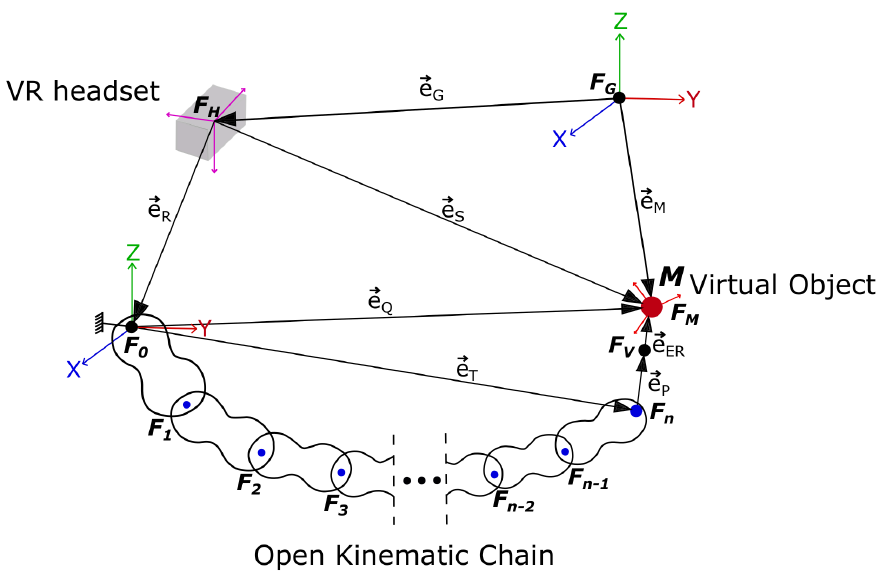
Figure 1. Kinematics Representation of n DoF Upper-Limb Exoskeleton with VR